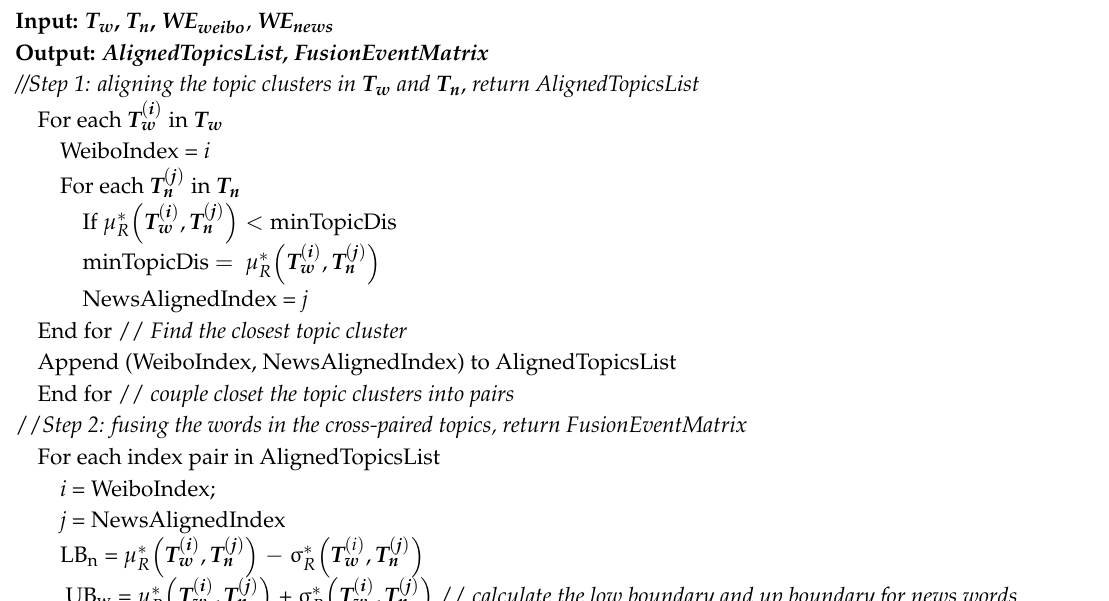
Algorithm 2. Transportation Events Alignment and